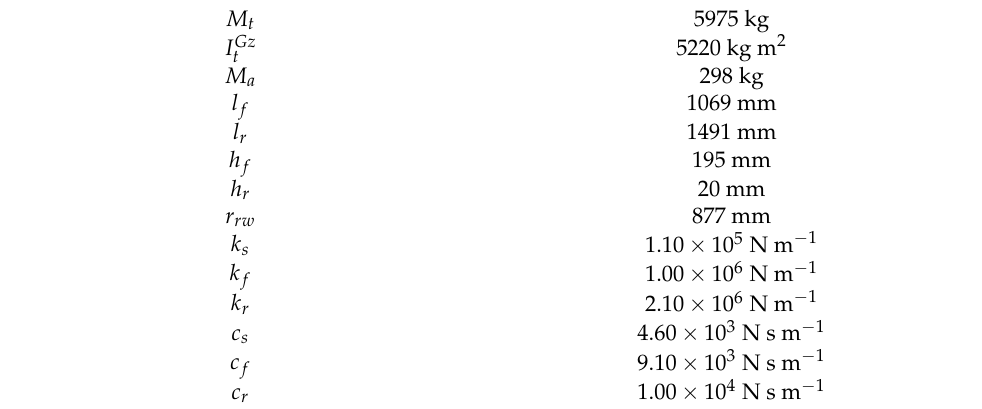
Table 4. Tractor parameters used in the tractor dynamic model.